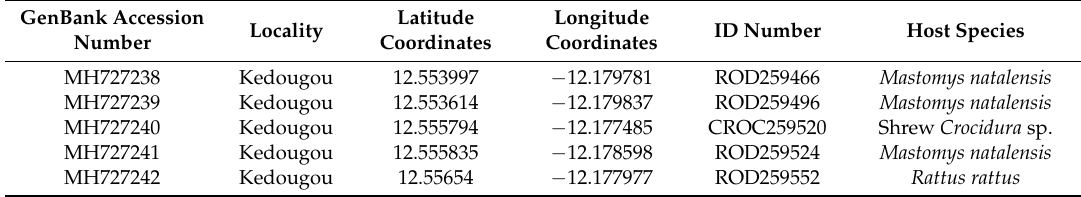
Table 1. Geographical positions of the five Usutu virus positive individuals.